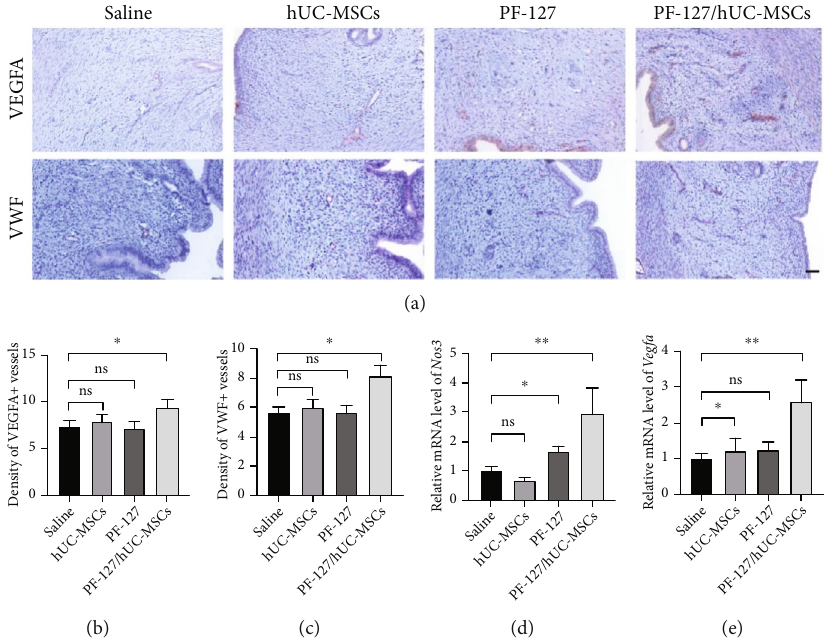
Figure 5: PF-127-encapsulated hUC-MSCs facilitate the angiogenesis of the damaged rat uterine. (a) IHC staining of angiogenesis markers (VWF and VEGFA). Scale bar = 50 μ m. (b) Quantitation of VEGFA-positive staining vessels. Data was reported as mean ± S : E : M . Student ’ s t -test was applied for signi fi cant di ff erence ( ∗ P < 0 : 05 and ns=nonsigni fi cant), n = 12 . (c) Quantitation of VWF-positive staining vessels. Data was reported as mean ± S : E : M . Student ’ s t -test was applied for signi fi cant di ff erence ( ∗ P < 0 : 05 and ns=nonsigni fi cant), n = 12 . (d, e) Q-PCR analyzed the relatively gene expression of angiogenesis markers ( Vegfa and Nos3 ). The expression values were normalized to 18S. Subsequently, the mRNA expression values were calculated as relative mRNA level versus mRNA expression values with saline injection, which was set to 1. Data was reported as mean ± S : E : M . Student ’ s t -test was applied for signi fi cant di ff erence ( ∗∗ P < 0 : 01 and ns=nonsigni fi cant), n = 12